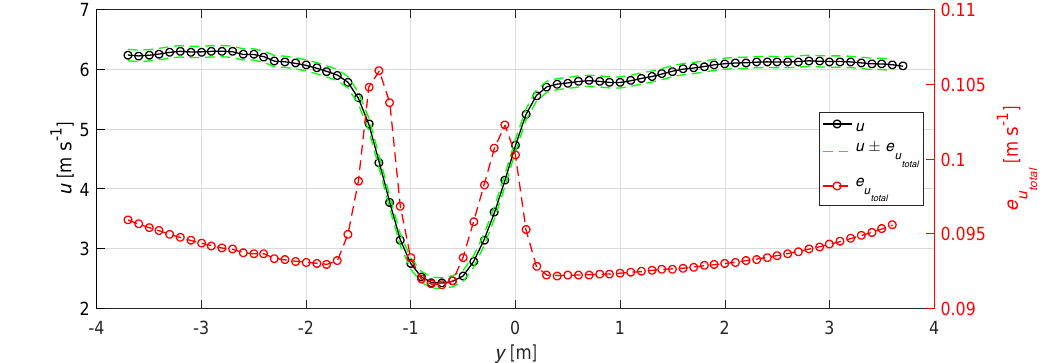
Figure 27. Average wake profile cross section at a 2 D downstream distance ( x = 2 . 2m) from the first turbine with the total error